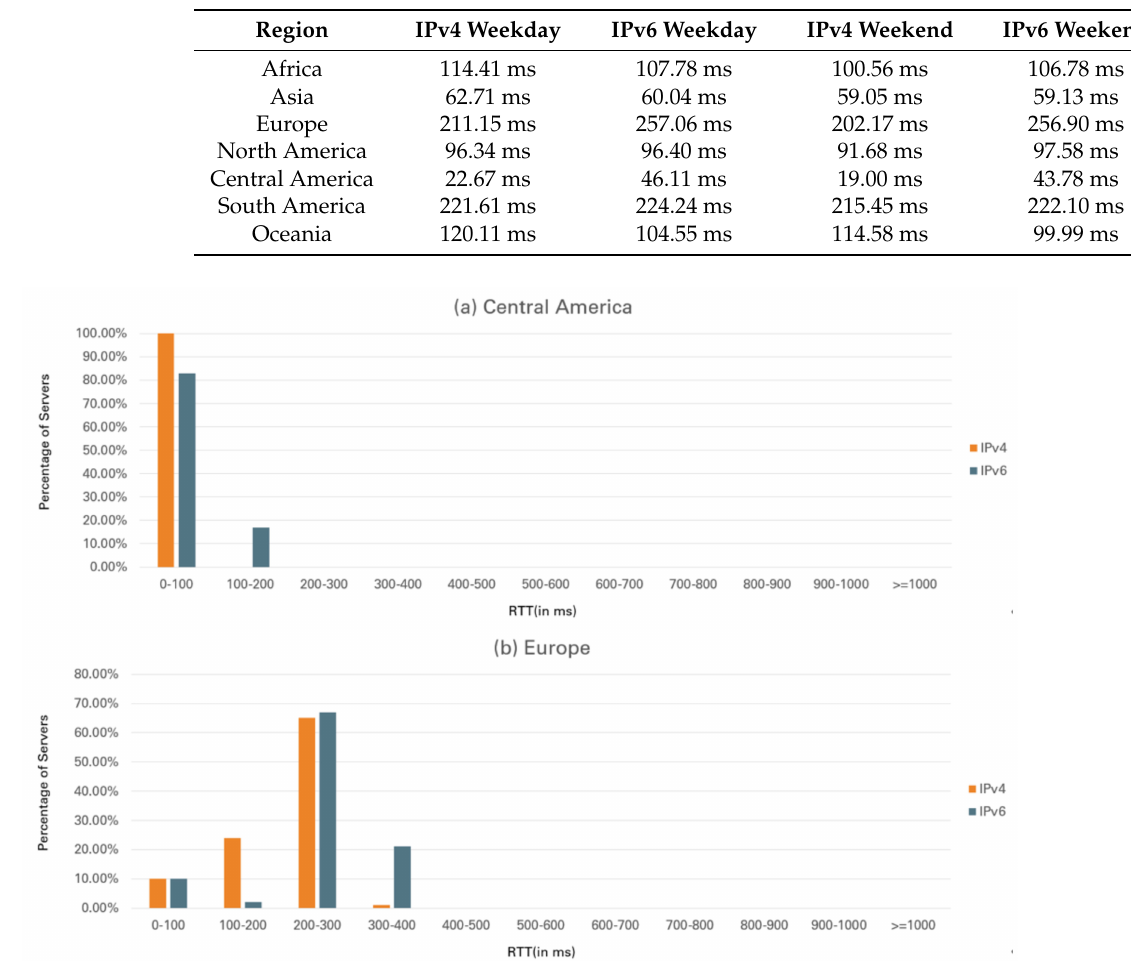
Figure 8. IPv4 vs. IPv6 RTT distribution on